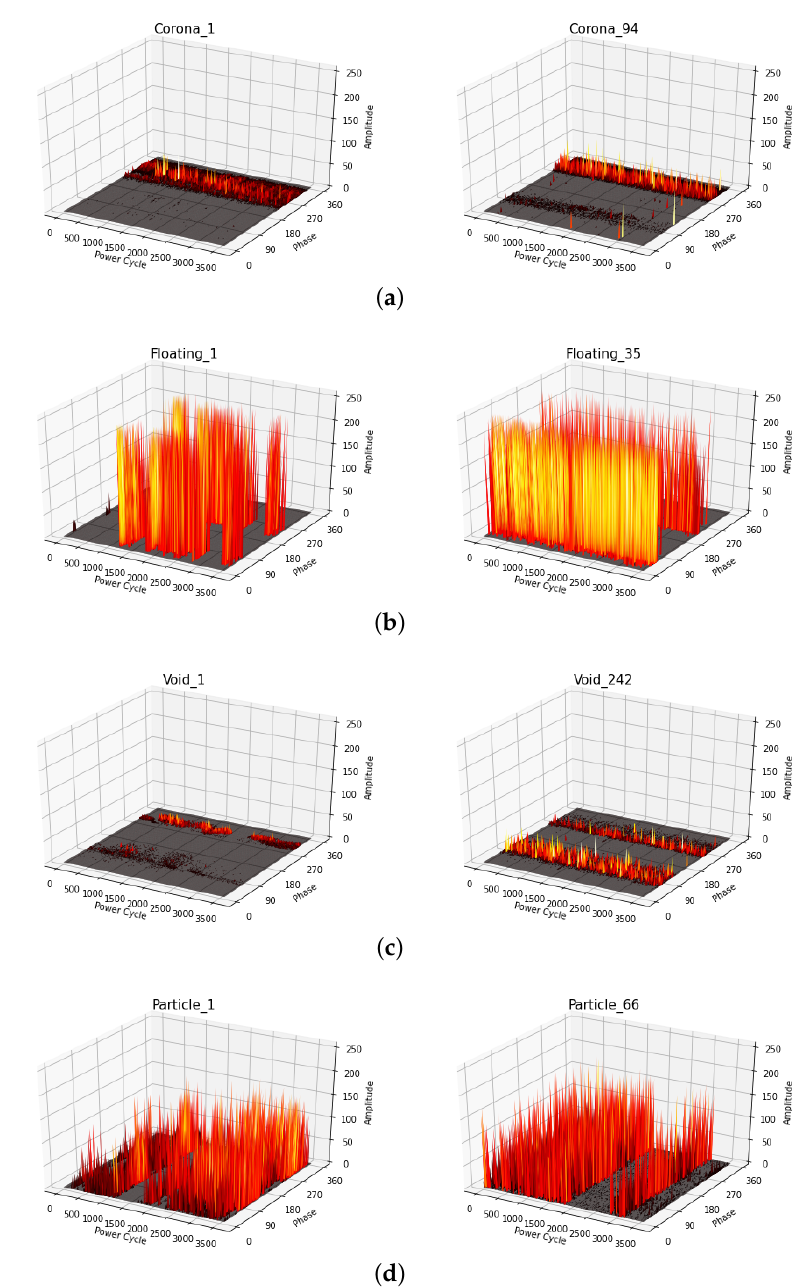
Figure 4. Discharge characteristics for the beginning ( left ) and the end ( right ) of PRPD measurements: ( a ) corona, ( b ) floating, ( c ) void, and ( d ) particle